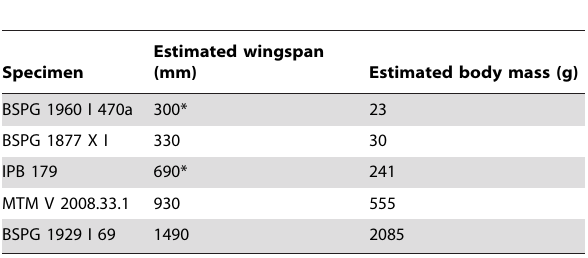
Table 2. Estimated wingspan and body mass of the five investigated